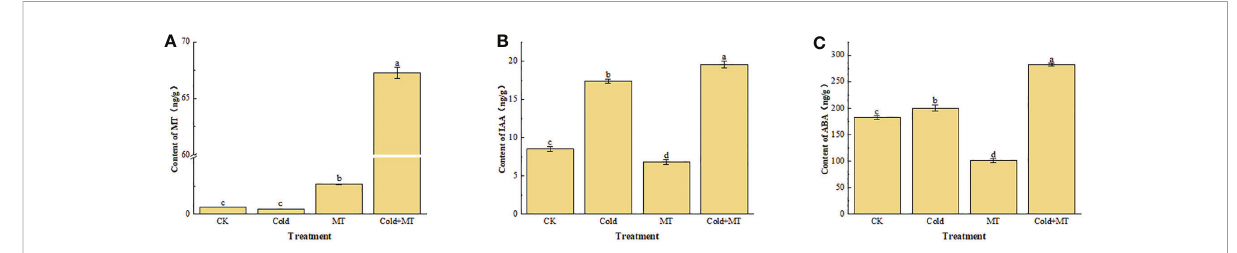
FIGURE 2 Effects of exogenous melatonin treatment on the content of hormone in soybeans. (A) the content of MT. (B) the content of IAA. (C) the content of ABA. Note: MT: Melatonin, IAA: Indoleacetic acid, ABA: Abscisic acid. Error bars represented the standard deviation (SD; n = 3). According to Duncan ’ s multiple tests, bars with different letters were signi fi cantly different (p <